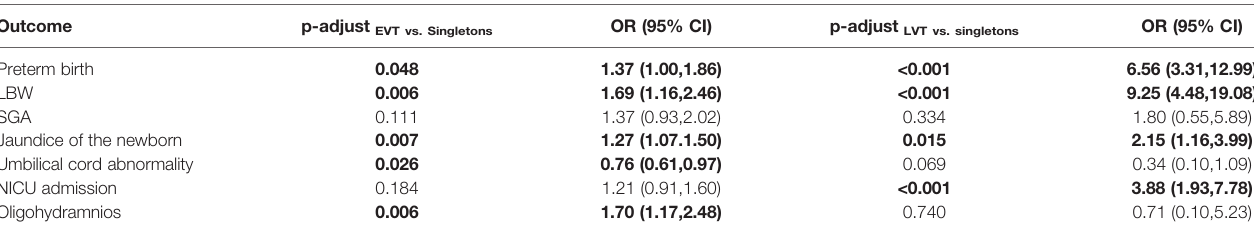
TABLE 3 | Logistic regression models of risk factors for adverse perinatal outcome. Outcome p-adjust EVT vs. Singletons